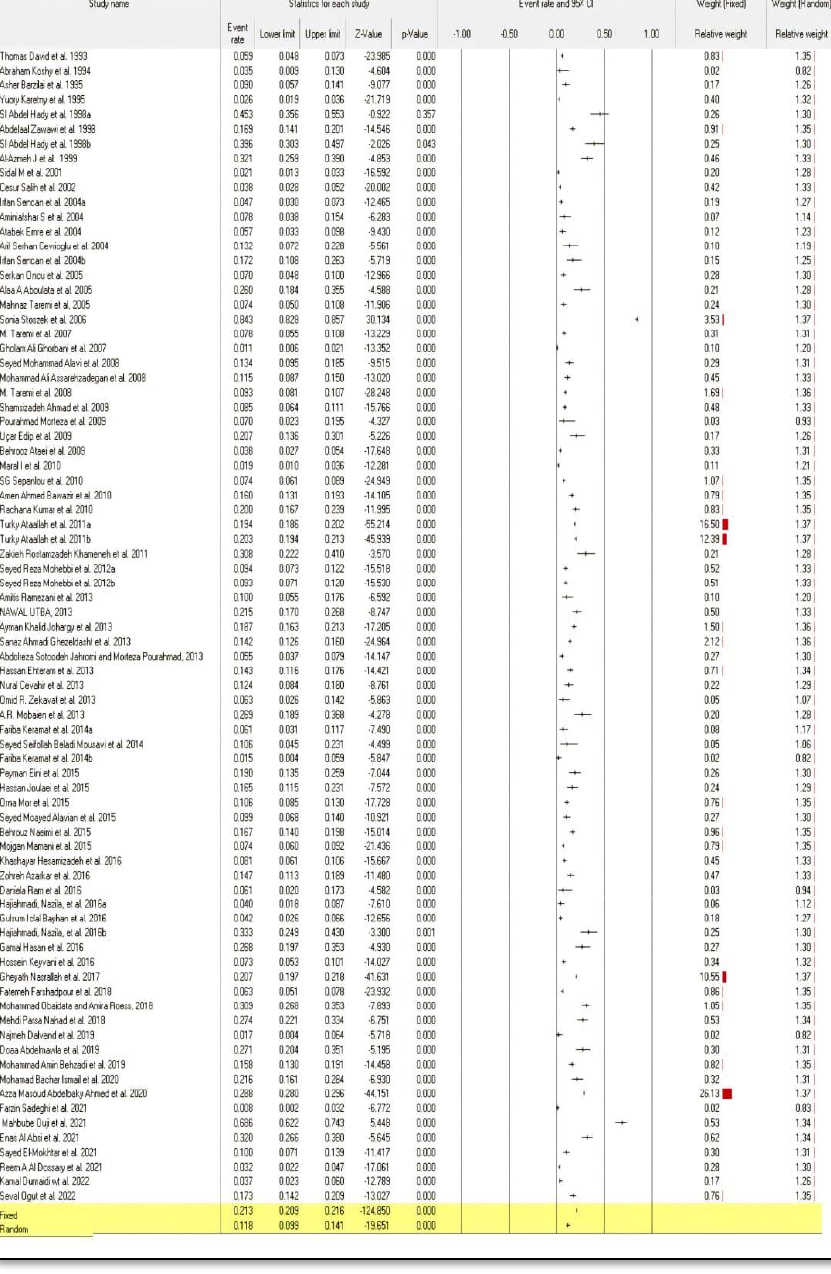
Figure 2. Forest plot meta-analysis of seroprevalence of hepatitis E virus infection in Middle Eastern countries.